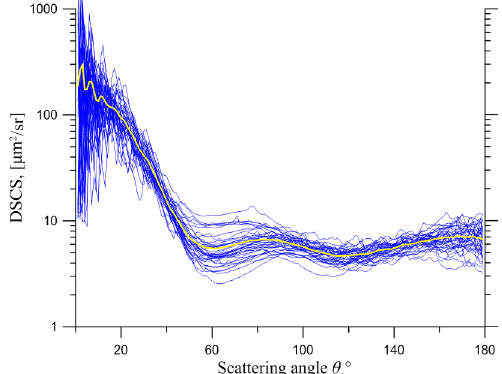
Figure 1. Differential scattering cross section obtained for a set of 50 ice particles of arbitrary shape. The yellow line – the average value over the entire set of particles DSCS scarcely deviated from the average